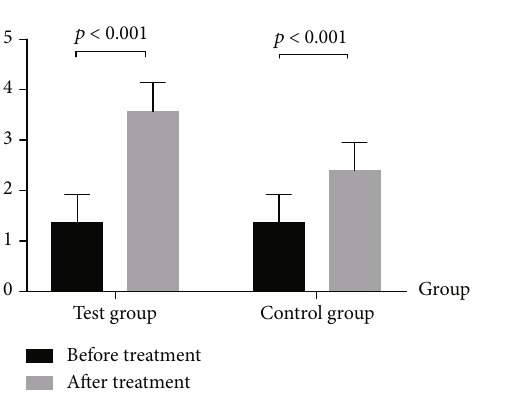
Figure 1: Ashworth ’ s modi fi ed spasticity classi fi cation of the gastrocnemius.